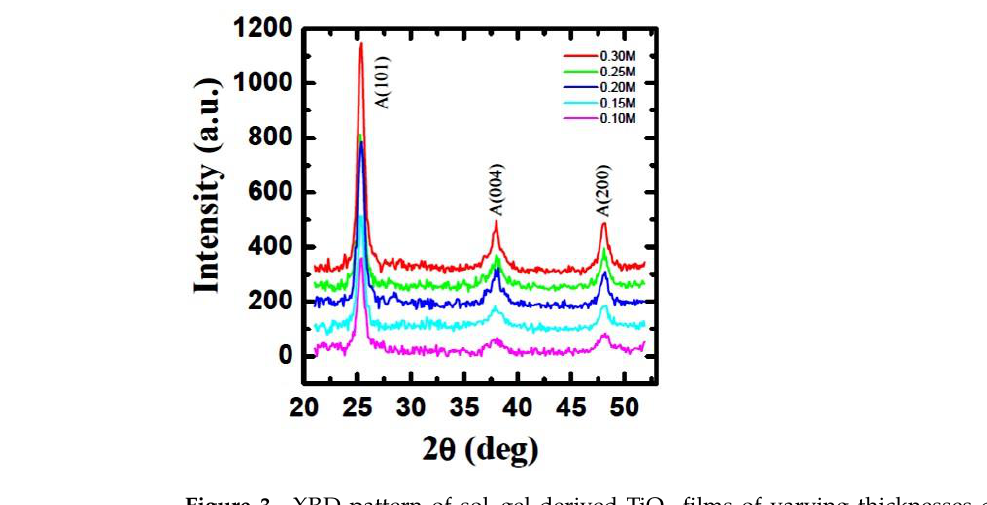
Figure 3. XRD pattern of sol–gel derived TiO 2 films of varying thicknesses coated on Si (100) substrates (A = Anatase phase of TiO 2 ).